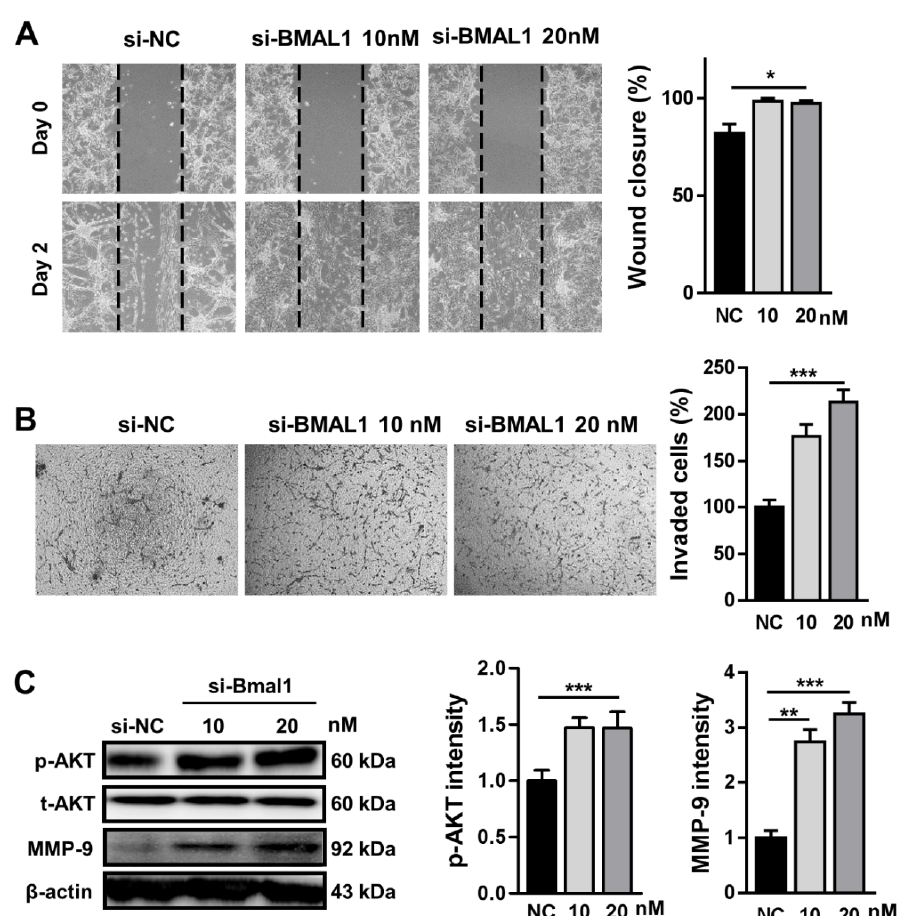
Figure 3. Knockdown of BMAL1 increased cell migration and invasion by upregulation of phosphorylated AKT (p-AKT) and matrix metalloproteinase (MMP)-9 in BMAL1 siRNA-transfected U87MG cells. ( A ) Cell migration was analyzed by a wound healing assay in si-NC and si-BMAL1 siRNA-treated U87MG cells at 48 h after scratching. Data are expressed as the mean ± SEM (one-way ANOVA test, * p < 0.05 vs. NC, three independent experiments). ( B ) Invasion of si-NC-and si-BMAL1-treated cells into the matrix were analyzed. Data are expressed as the mean ± SEM (one-way ANOVA test, *** p < 0.001 vs. NC, three independent experiments). ( C ) Expression levels of p-AKT and MMP-9 were analyzed by Western blot in si-NC- andsi-BMAL1-treated U87MG cells. Data are expressed as the mean ± SEM (one-way ANOVA test, ** p < 0.01 and *** p < 0.001 vs. NC, three independent